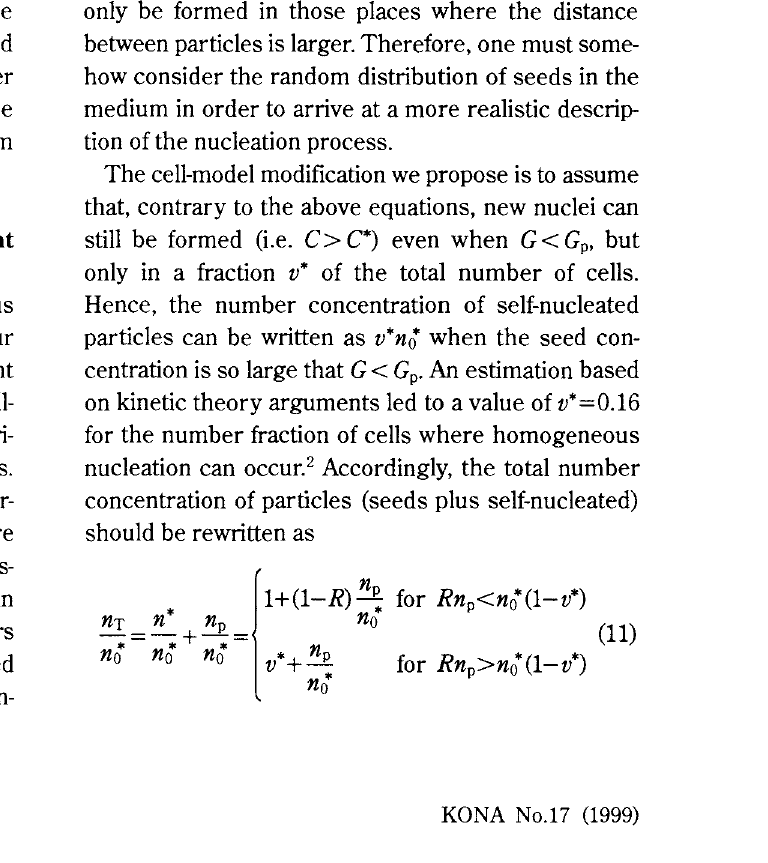
Fig. 3 Effect of the random spatial distribution of seeds on the monomer concentration profile in their